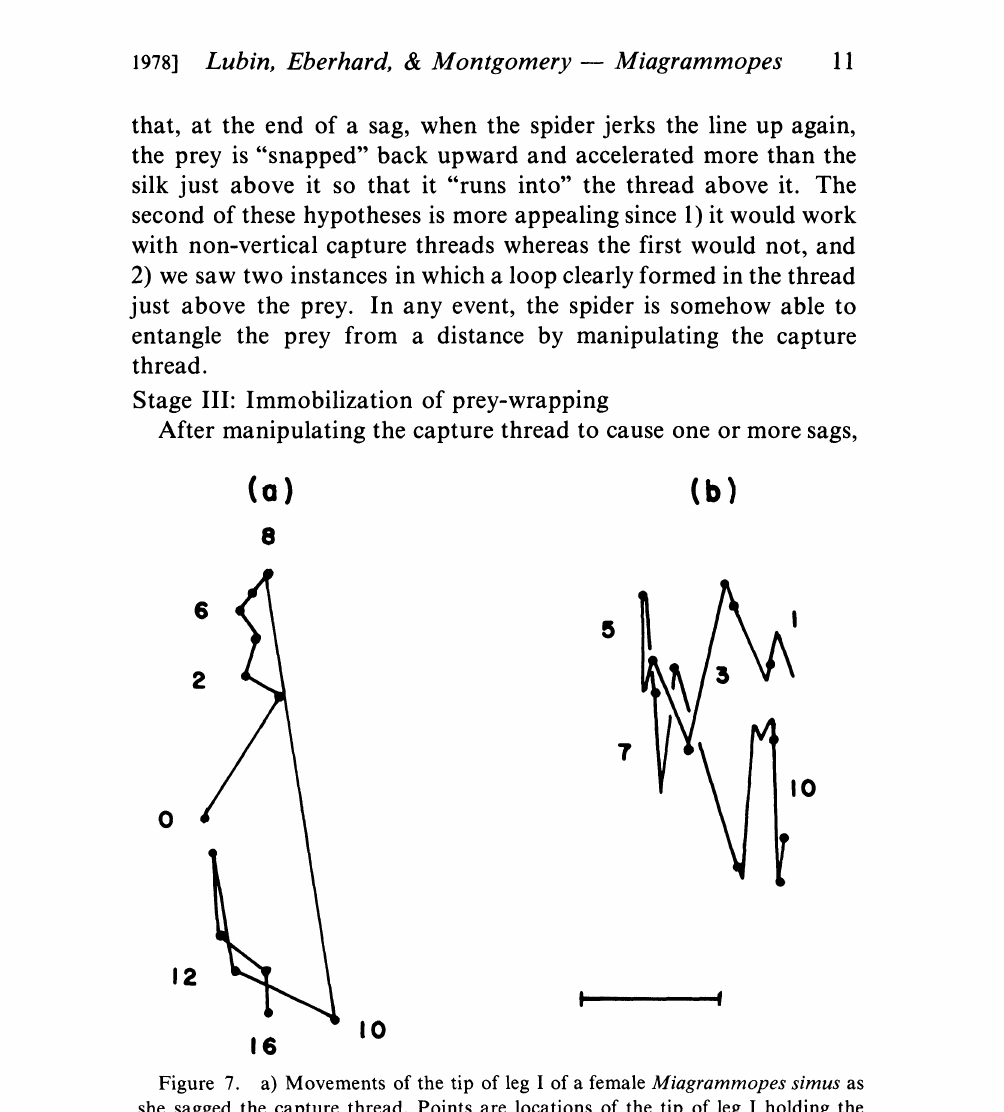
Figure 7. a) Movements of the tip of leg of a female Miagrammopes simus as she sagged the capture thread. Points are locations of the tip of leg holding the capture thread, taken from a video-taped sequence with "frames" !60 sec apart. In frames 3-5 the tip of the leg remained in the same spot. In frames 9 and 11 the tip of the leg was not visible; these points are not shown in the figure, b) Movements of a prey on the capture thread while the thread is being sagged and jerked back up and down, taken from a video-taped sequence (as above). Numbers refer to segments of the path of movement of the prey on the line during consecutive 60 sec intervals. Scale marker represents 10